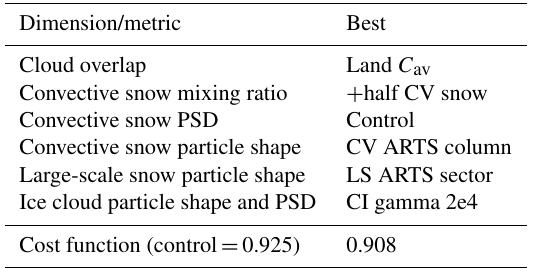
Table 4. Results of parameter